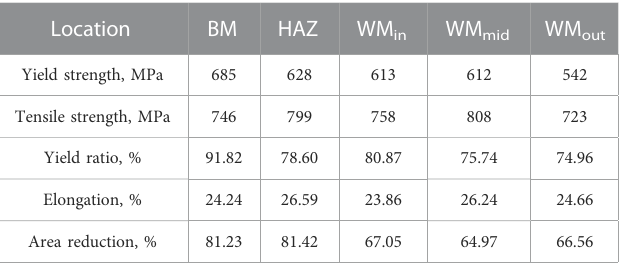
TABLE 1 Tensile properties of the welded